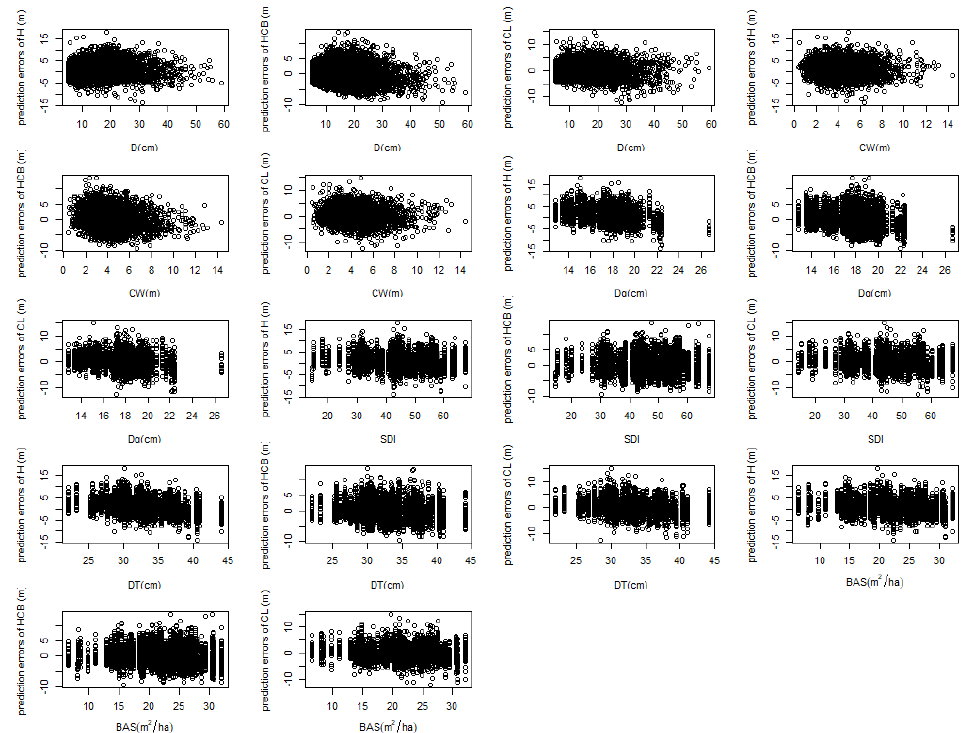
Figure 9. Prediction errors against predictors of Equation (19) ( D : diameter at breast height (cm); CW : crown width (m); Dg : mean quadratic D (cm); SDI : stand density index; DT : stand dominant D (cm); BAS : stand basal area (m 2 ·ha − 1 )).